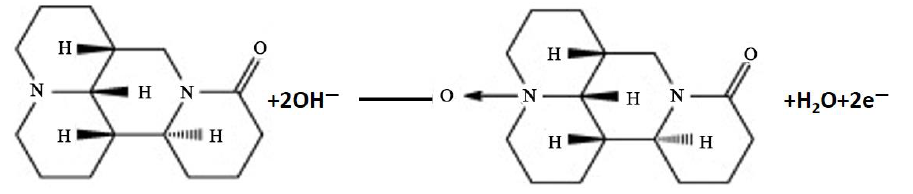
Figure 4. Oxidation mechanism of MT on GNs/HA/GCE.